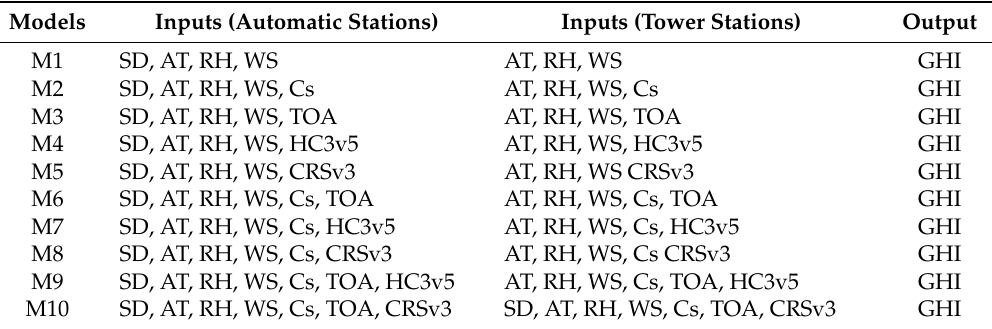
Table 4. Inputs and output to the ANN